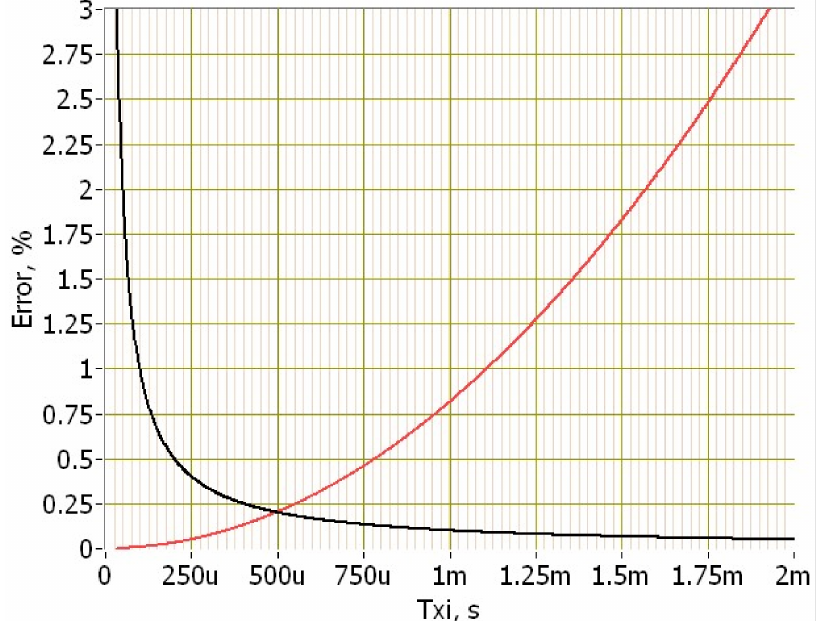
Figure 6. Summary of sample quantization error and averaging waveforms for F = 1 Hz and f 0 = 1 MHz. The red line curve shows the course of the averaging error; the black line curve shows the plot of the quantization